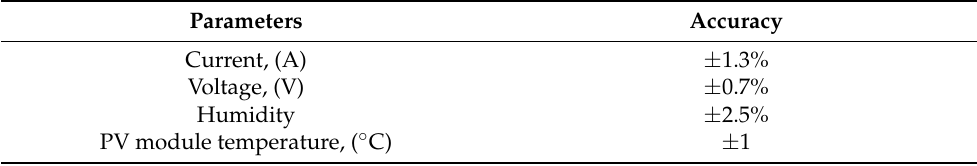
Table 3. Accuracy of the measuring devices.